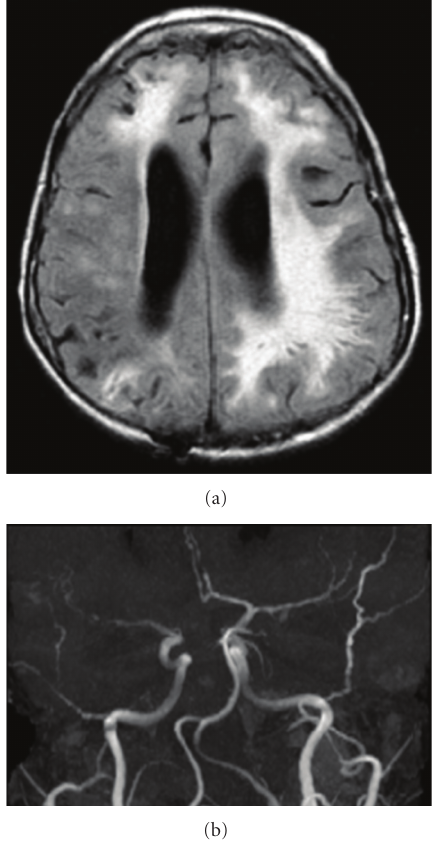
Figure 1: (a) Three mm axial fluid attenuated inversion recovery (FLAIR) brain magnetic resonance images (MRIs) demonstrating extensive subcortical white matter hyperintensity. (b) Magnetic resonance angiogram (MRA) demonstrating beading of small and medium intracranial